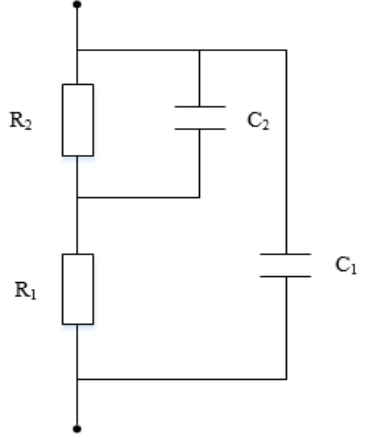
Figure 2. Model of arrestor simulation.